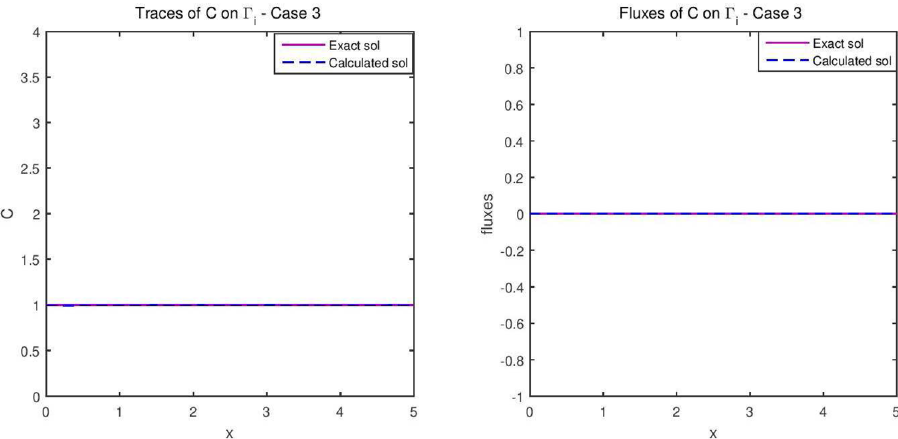
Figure 9. The reconstructed concentration—Case